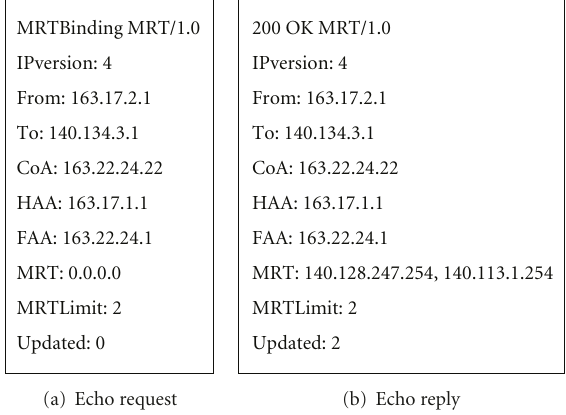
Figure 4: An example of payload of echo request/reply messages.